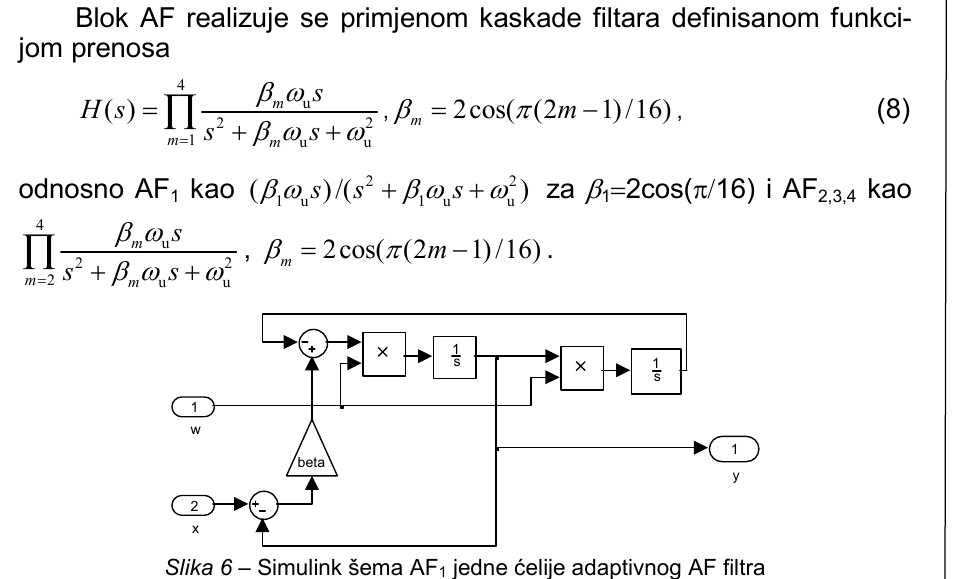
Figure 6 – Simulink scheme AF 1 of one block in the adaptive AF filter